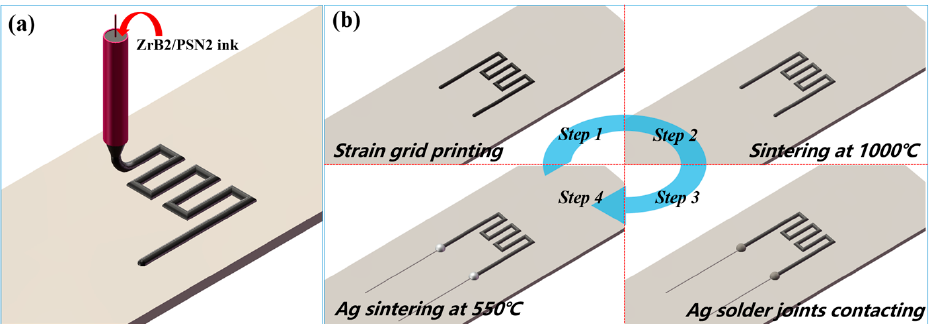
Figure 1. ( a ) Direct ink writing patterning of the strain gauge; ( b ) Schematic of the ZrB 2 /SiCN thin- film strain gauge fabrication process.